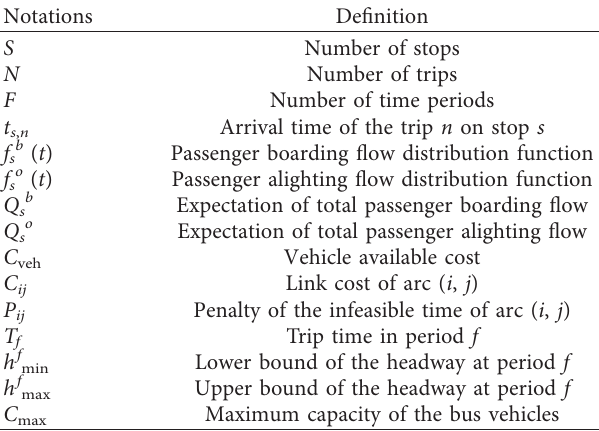
Table 2: Subscripts and parameters of the problem formulation.